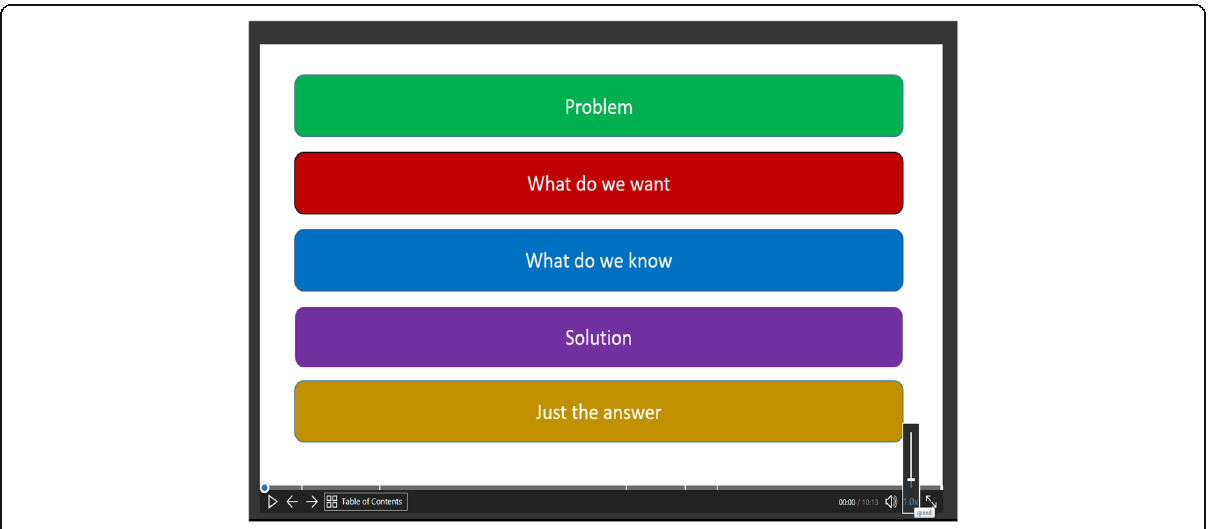
Fig. 1 Screenshot showing the commencement of the short video embedded